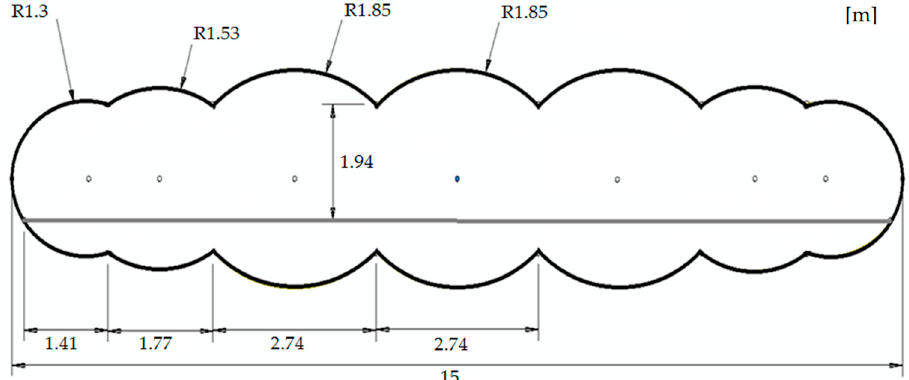
Figure 2. Multi-bubble cross section of the inner shell with floor.